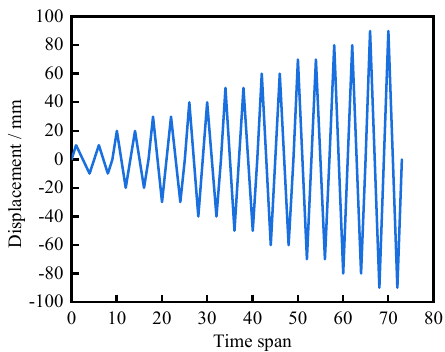
Figure 10. Reciprocating cyclic loading system.